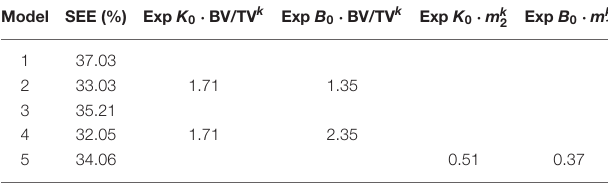
TABLE 4 | SEEs, BV/TV, and fabric eigenvalue exponents for the isotropic and anisotropic models.